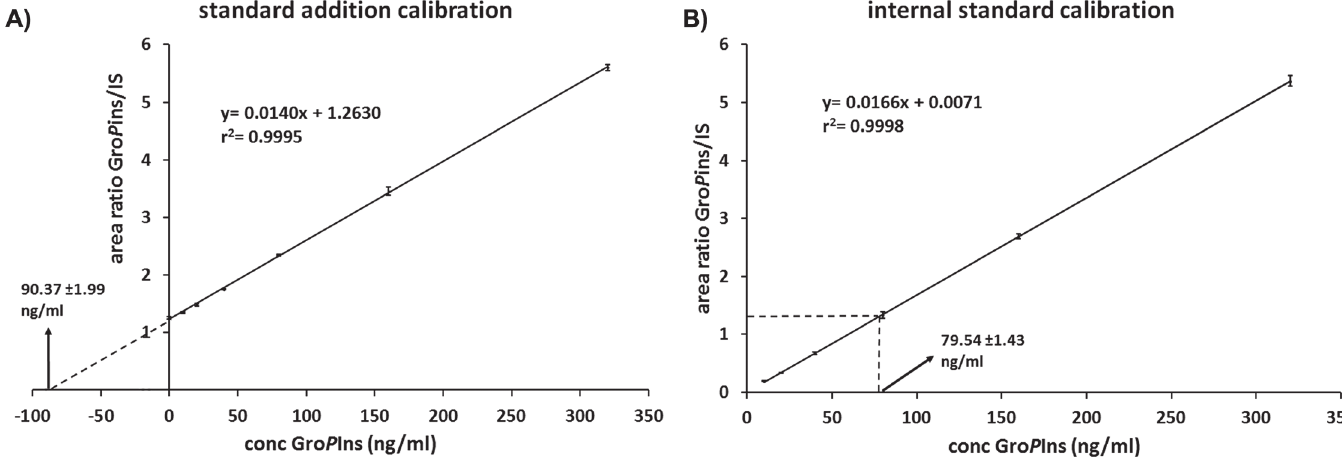
Fig 4. Linearity of Gro P Ins and analyte concentration in Raw 264.7 cell extract. (A) Standard addition calibration in matrix. (B) Internal standard calibration in water. Error bars are expressed as SD.